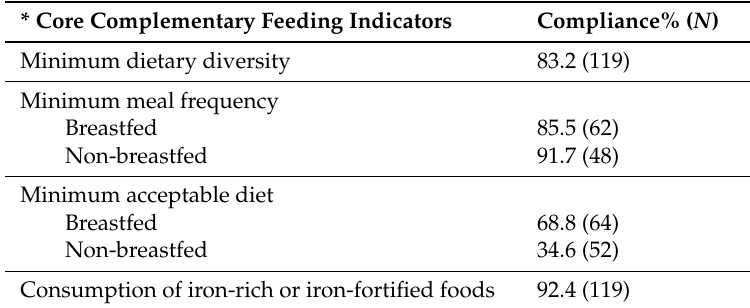
Table 2. Compliance (%) with WHO core complementary feeding indicators by sub-group ( N = 119).